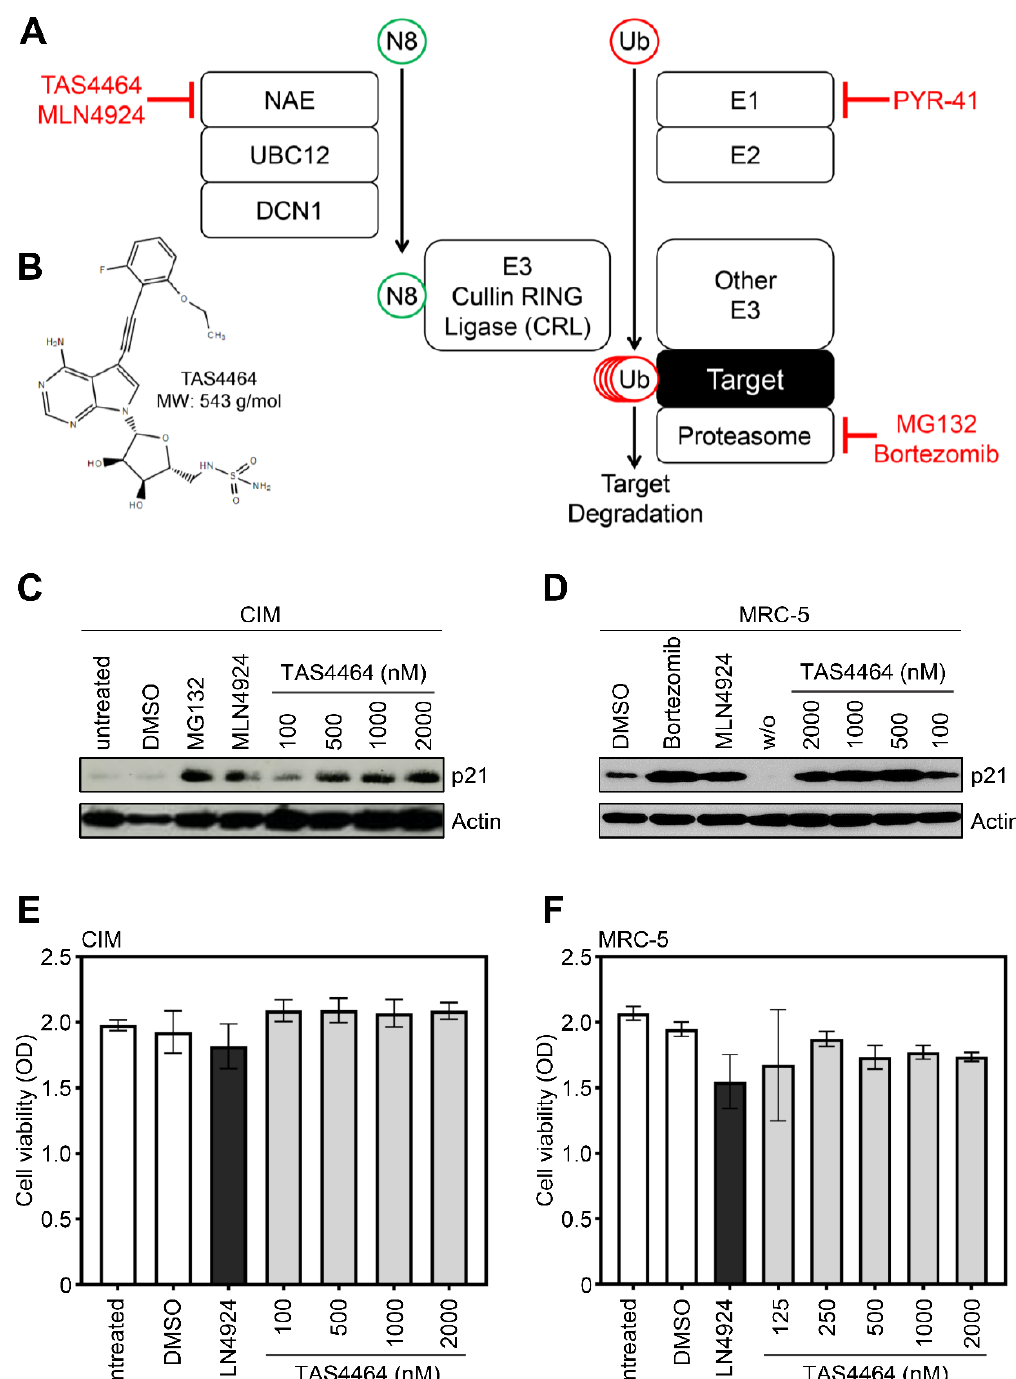
Figure 1. TAS4464 stabilizes CRL targets such as p21, and does not exert overt cytotoxicity. ( A ) Simplified overview of the conjugation of ubiquitin (“Ub”) and Nedd8 (“N8”), as well as target protein degradation through the proteasome. Inhibitors are depicted in red. Please, see the main text of the article for further details and abbreviations. ( B ) The molecular structure of TAS4464 (PubChem CID: 124121823) is shown. ( C ) C57BL/6 immortalized mouse embryonic fibroblasts (“CIM”) and ( D ) human MRC-5 cells were treated with MG132 (1 µ M), MLN4924 (5 µ M), or the indicated concentrations of TAS4464 (100–2000 nM). Solvent-treated (“DMSO”) and untreated cells served as controls. After 24 h, cells were lysed and subjected to immunoblot analysis to determine the p21 abundance. ( E ) CIM cells were treated with MLN4924 (5000 nM), TAS4464 (100–2000 nM), the solvent (“DMSO”), or were left untreated for 72 h. Afterwards, the cytotoxicity was determined as described in the Materials and Methods section. ( F ) As in ( E ), but human MRC-5 cells were